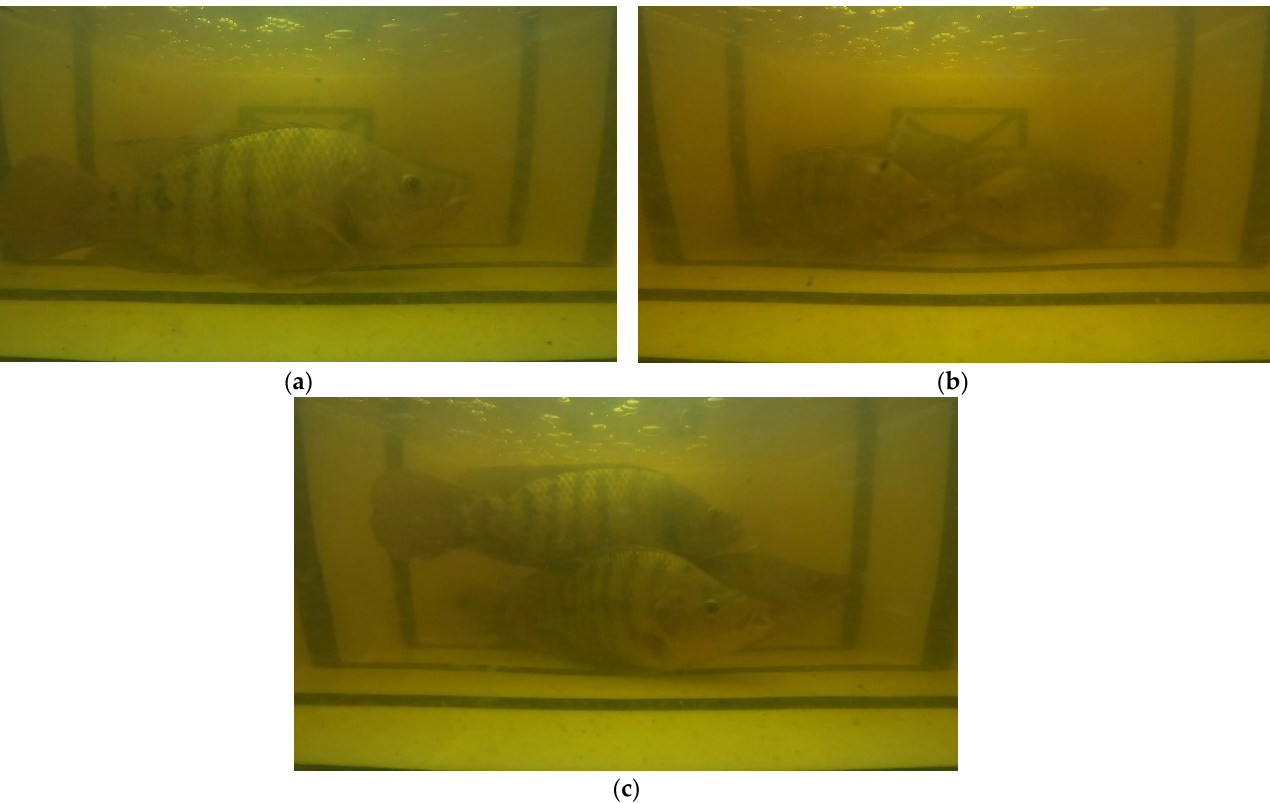
Figure 6. Sample of observed Tilapia in turbid water where ( a ) a single Tilapia; ( b ) two Tilapia with more than 50% of a body size appearance; ( c ) multiple Tilapia overlapping.